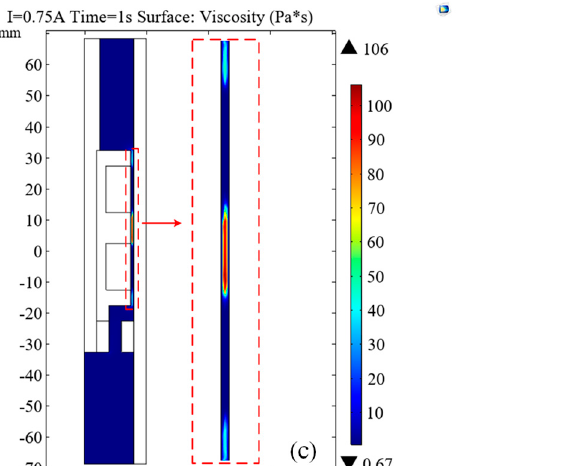
Figure 9. Dynamic viscosity distribution for: ( a ) I = 0.25 A; ( b ) I = 0.5 A; ( c ) I = 0.75 A; and ( d ) I = 1 A.